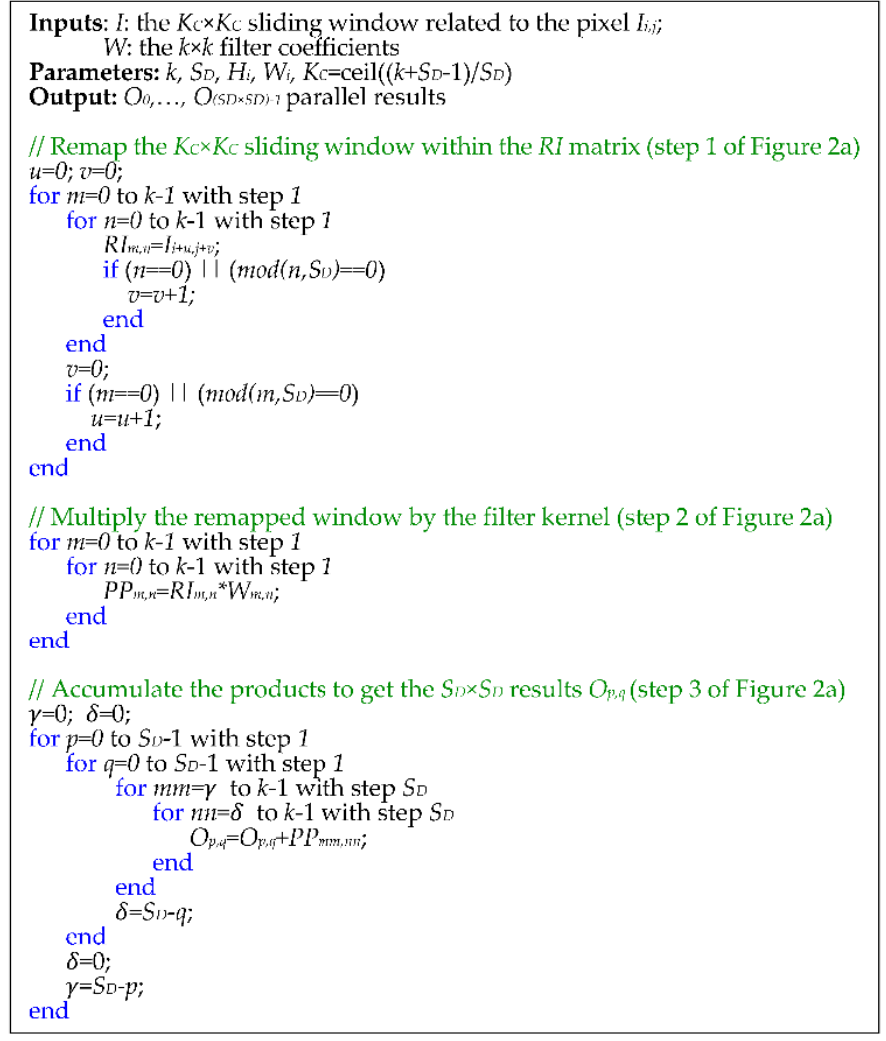
Figure A1. Software model of the proposed approach.